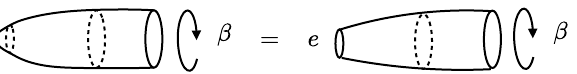
Figure 1 . The left figure shows the cigar geometry which is the saddle point that contributes the area term in the generalized entropy. On the right we have removed a cap at the tip of the cigar and inserted a shrinkable boundary condition e .